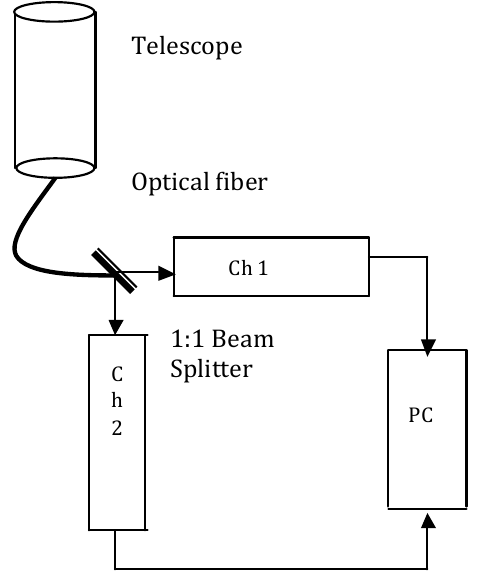
Figure 2. Receiver set-up of the lidar system used for testing the SNR improvement.